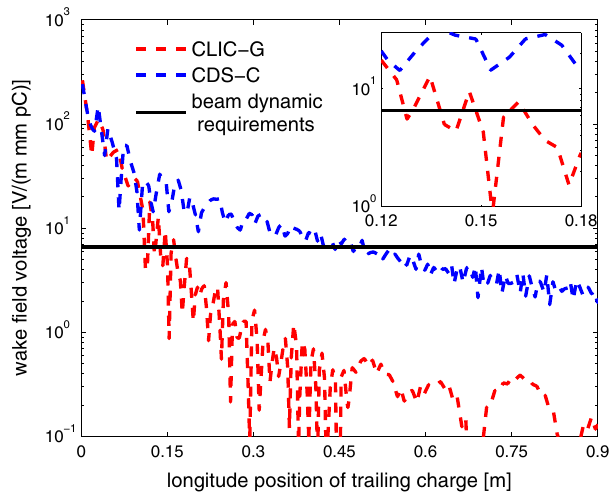
FIG. 5. Transverse wakefield potential of CDS-A (24 tapered cells with ordinary 1-mm gap radial choke).